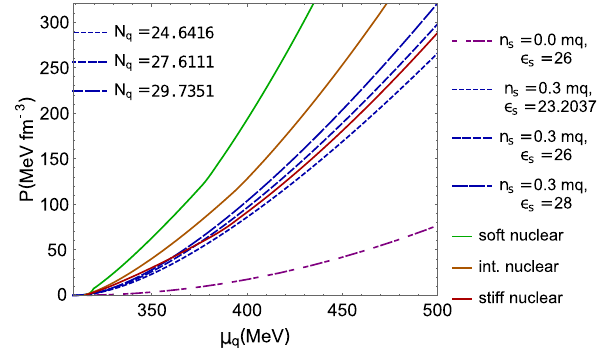
Fig. 2 P − μ diagrams of multiquark comparing to stiff, intermediate and soft nuclear matter when the onset chemical potential value per quark is set to 308.55 MeV. The energy density scale for the multiquark SS model is set to (cid:2) s = 23 . 2037 , 26 , 28 GeV/fm 3 (three blue dashed lines)